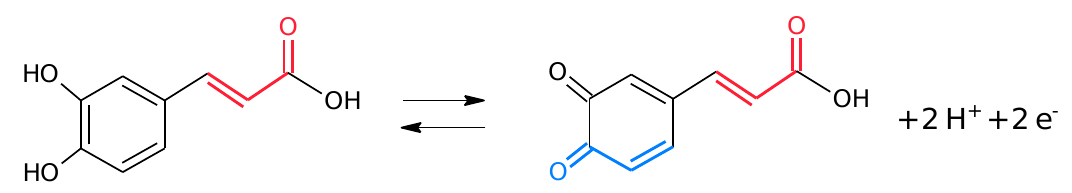
Figure 1. Schematic representation of caffeic acid (CFA) and the relevant oxidized, o -quinone form. The colored functional groups represent the potential Michael acceptors exploitable for anchoring the molecule at the carbon-based